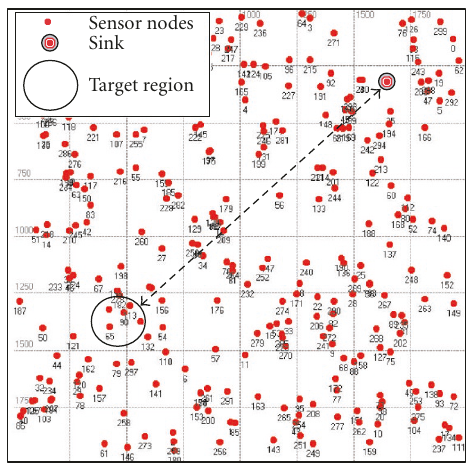
Figure 8: Sensor network model.